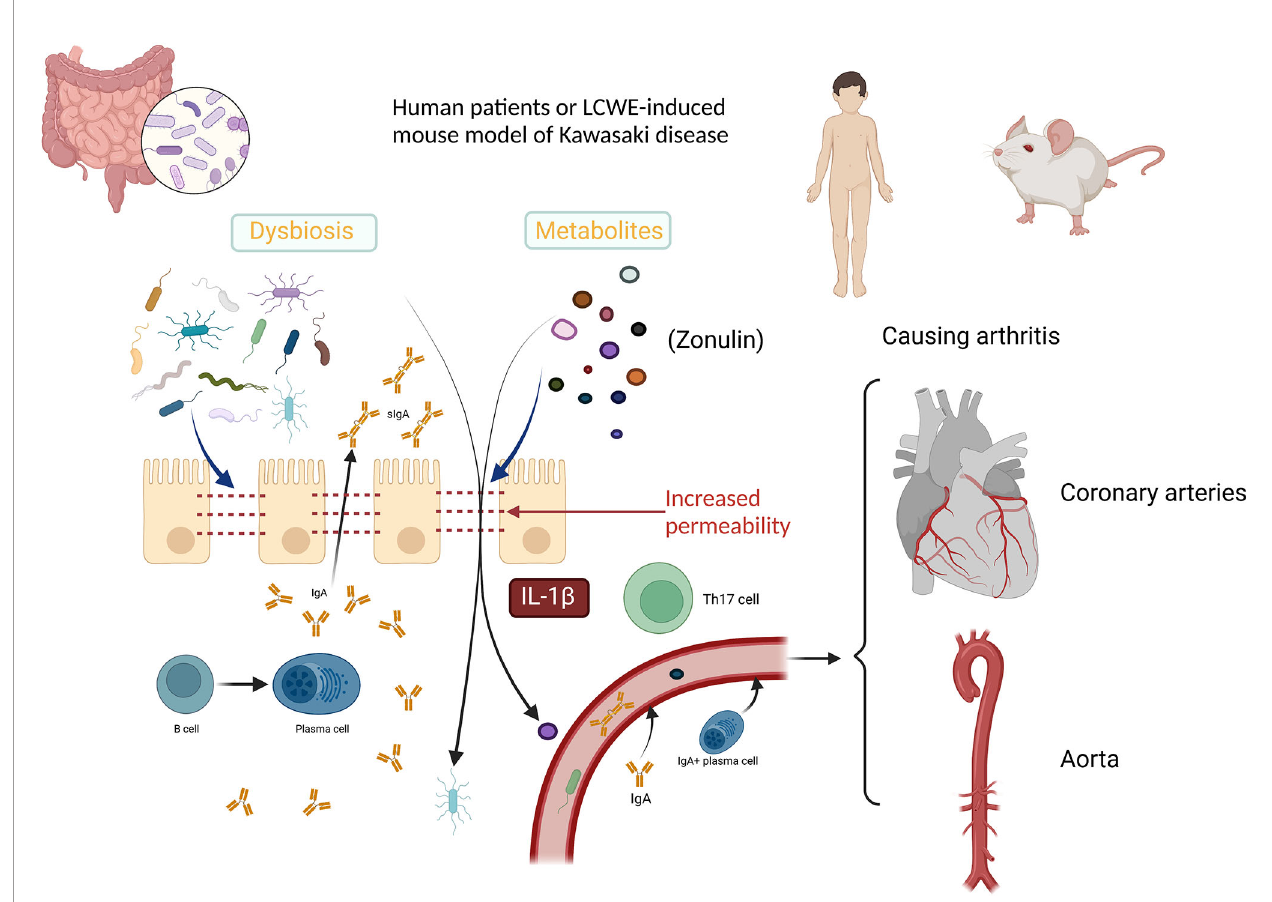
FIGURE 1 | Potential mechanism between intestinal microbiome dysbiosis and Kawasaki disease. The increased permeability, probably caused by the immune response to dysbiosis, allows the microbiota and metabolites to get through the intestinal epithelial barrier. Abnormal in fl ammatory status involving increased production of IL-1 b and Th17 contributes to the permeability increase. Microbiota, metabolites, and sIgA spread systemically along with the IgA+ plasma cell perforates into the vessel wall. IgA, immunoglobin A; IL-1 b , interleukin-1 b ; LCWE, Lactobacillus-cell wall extract; sIgA, secretory Immunoglobulin A; Th17 cells, T helper 17 cells; ZO-1, zonula occludens-1. Created with